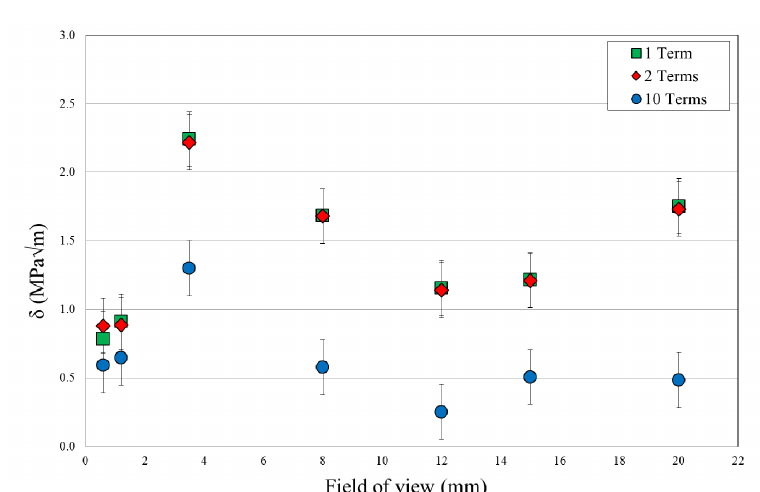
Figure 5. Difference between theoretical and experimental SIF, δ , as a function of FOV for different number of Williams’ terms.